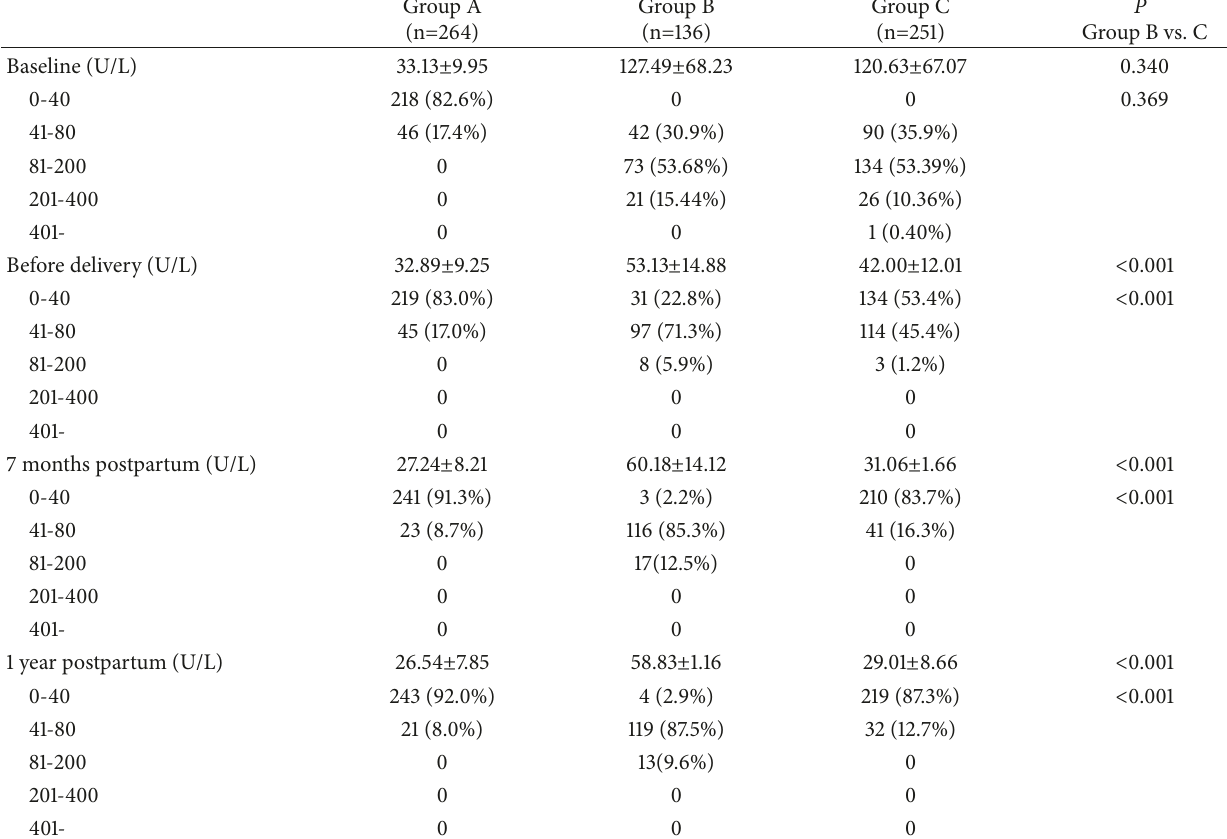
Table 3: ALT levels of the pregnant women during pregnancy and postpartum.